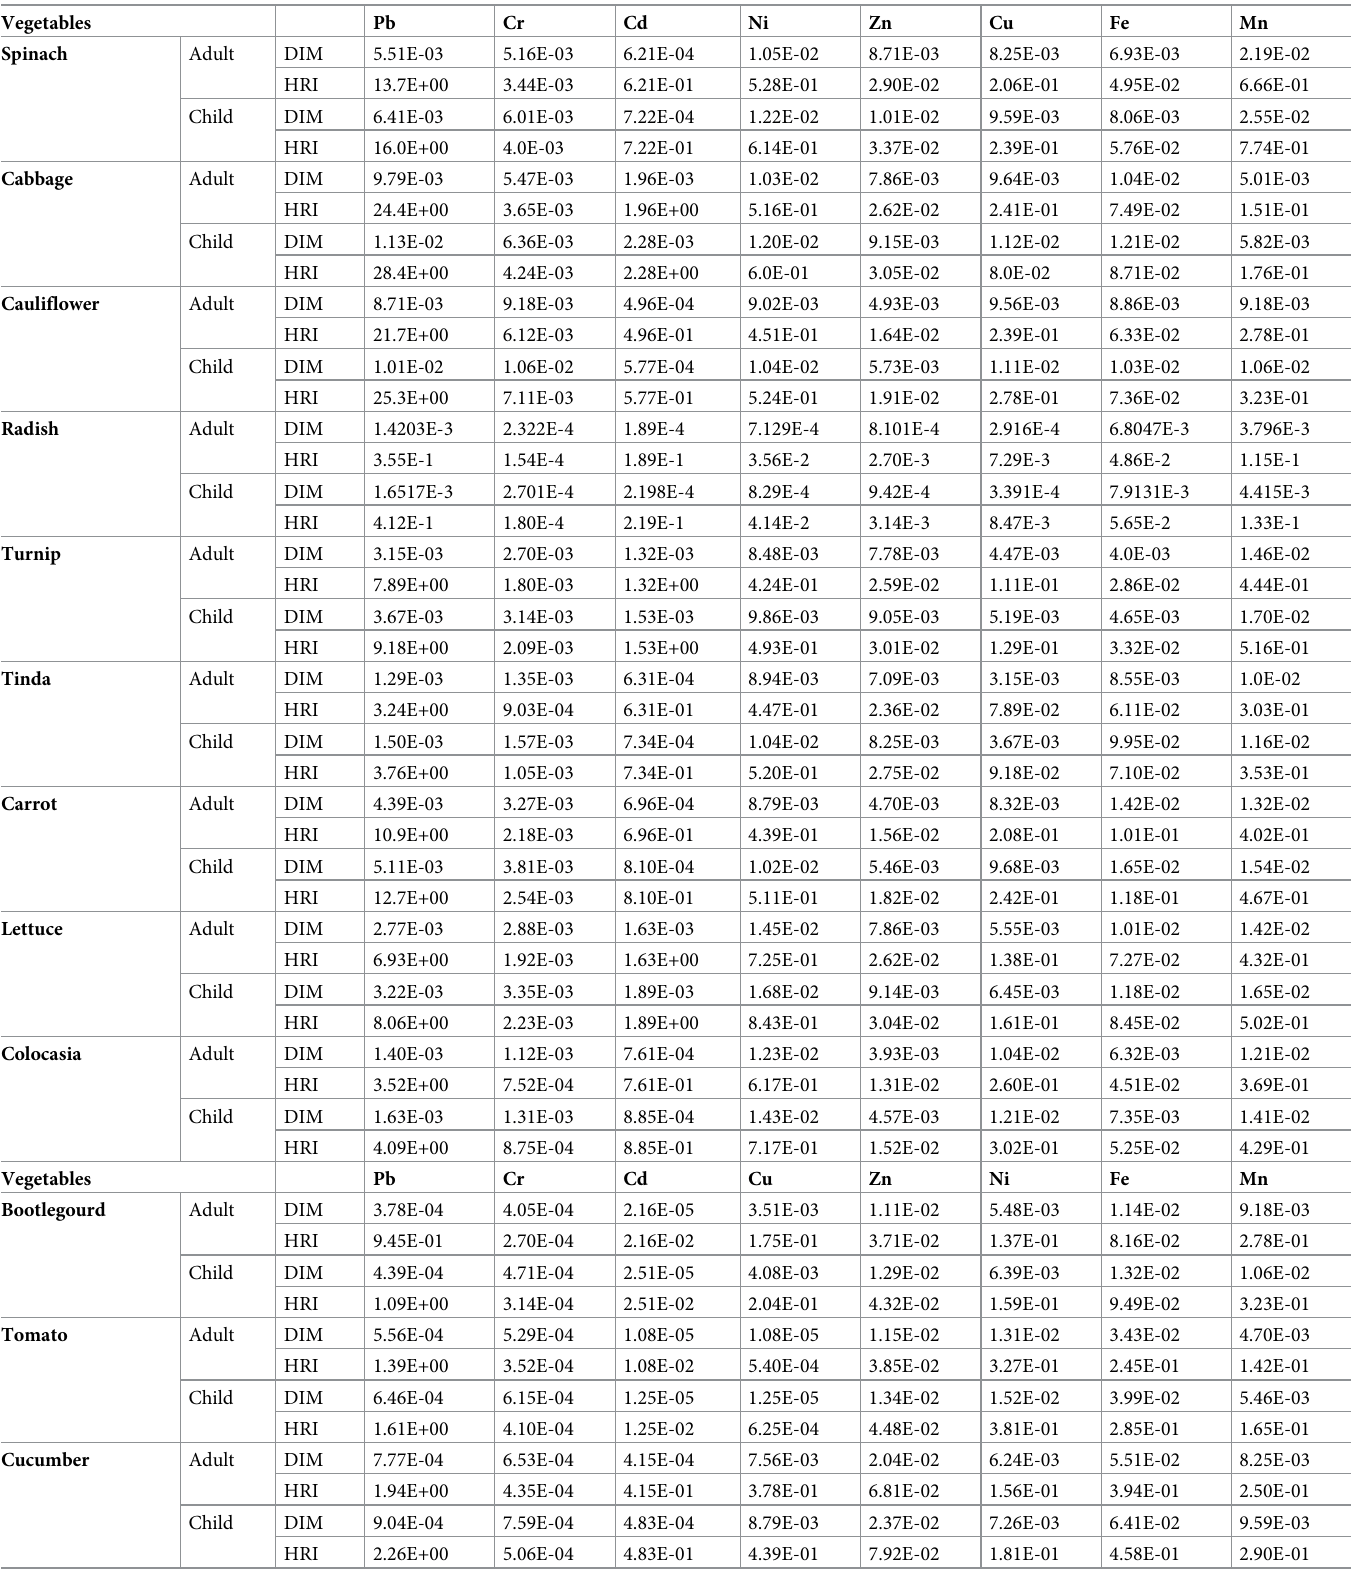
Table 6. DIM and HRI for wastewater irrigated vegetables of district Swabi.